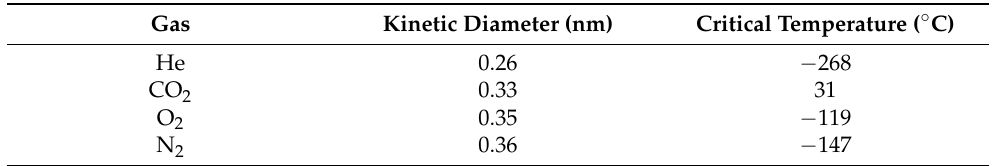
Table 1. Kinetic diameter and critical temperature of the various investigated gases. Data retrieved from ref. [49]. Gas Kinetic Diameter (nm) Critical Temperature ( ◦ C) He 0.26 − 268 CO 2 0.33 31 O 2 0.35 − 119 N 2 0.36 −